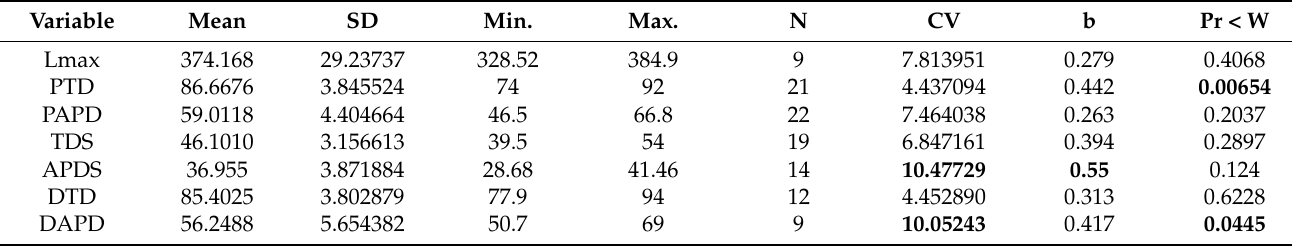
Table 1. Sex-combined statistics for radius